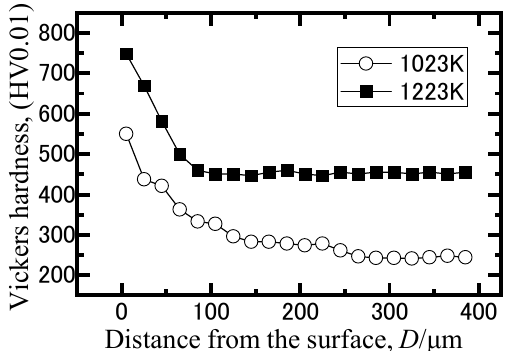
Figure 2. Micro Vickers hardness distribution from the surface after GNQP.